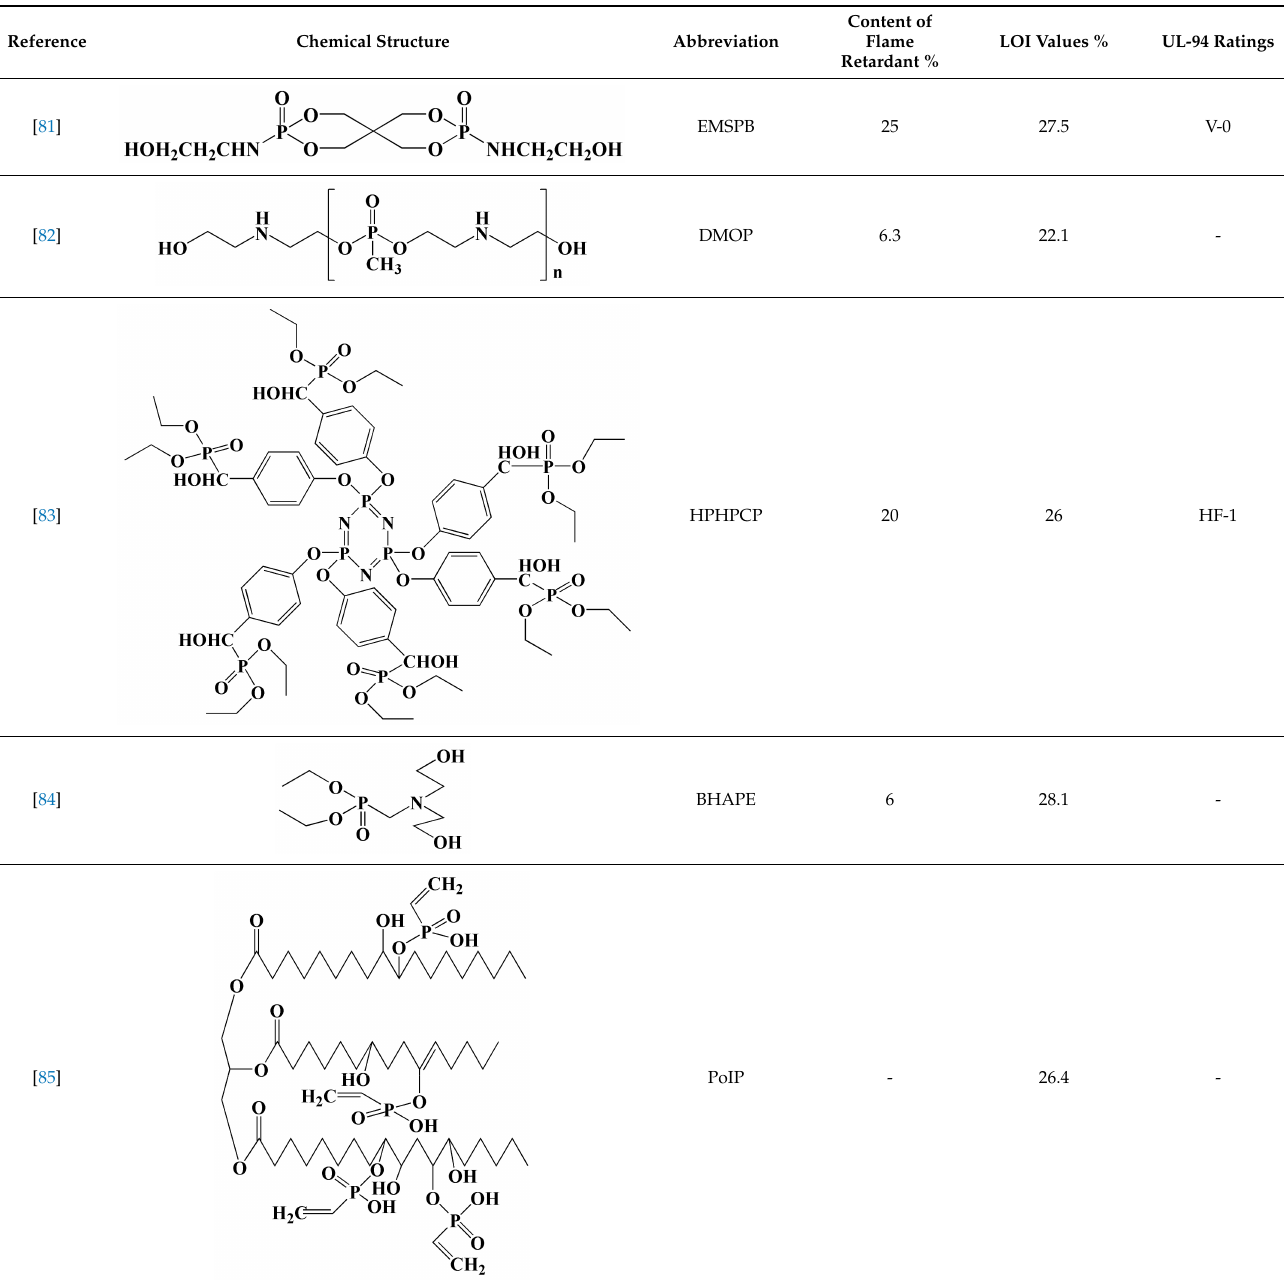
Table 2. Chemical structures of flame-retarded polyols with built P and N